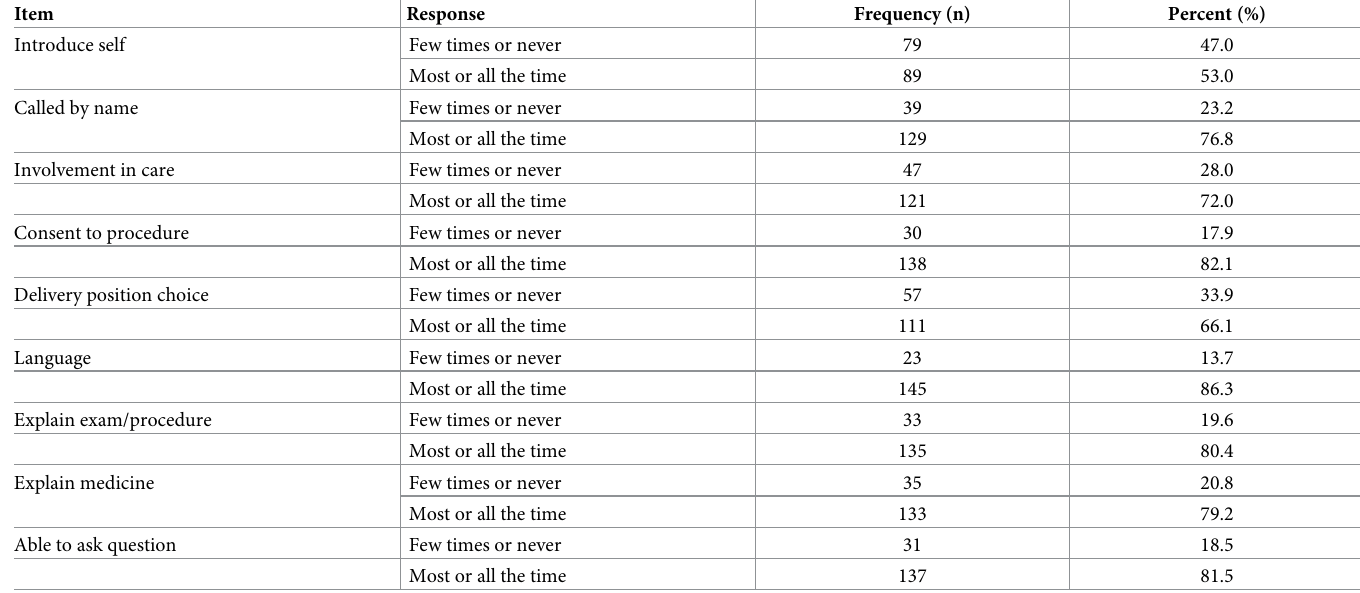
Table 3. Distribution of communication and autonomy items among